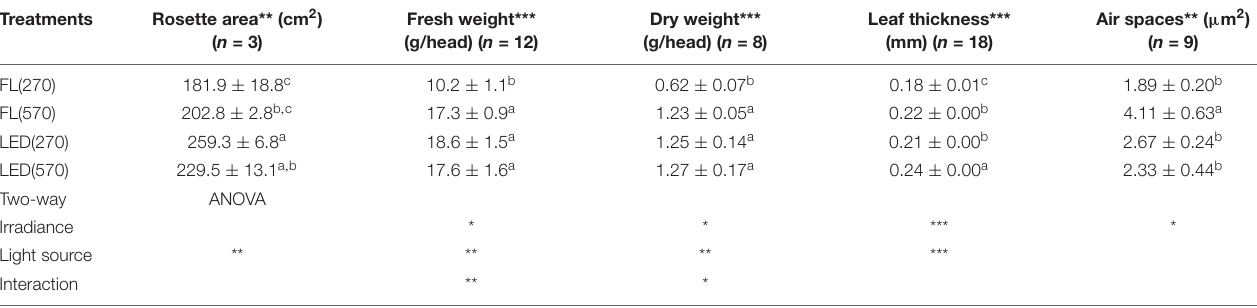
TABLE 2 | Growth responses and leaf structural traits of Lollo rosso lettuce (30 DAS) growing under the same high and low irradiances of fluorescent, FL(270) and FL(570), and LED, LED(270), and LED(570), light. Treatments